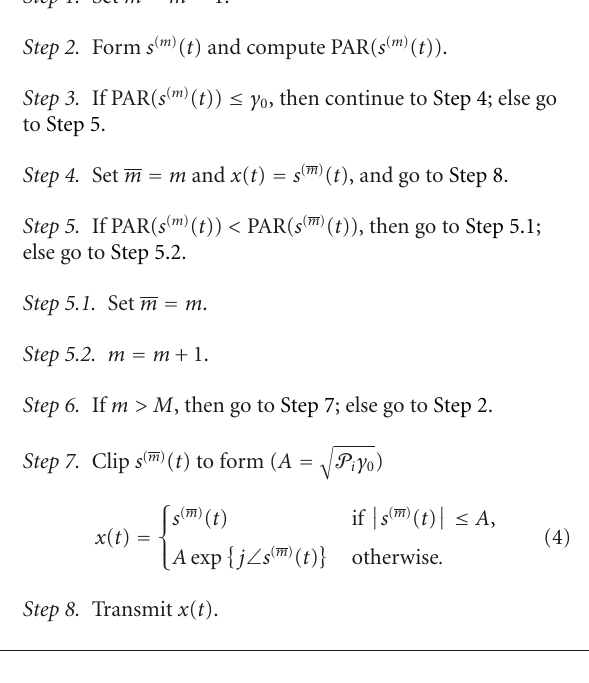
Algorithm 1: SLM with thresholding and clipping.